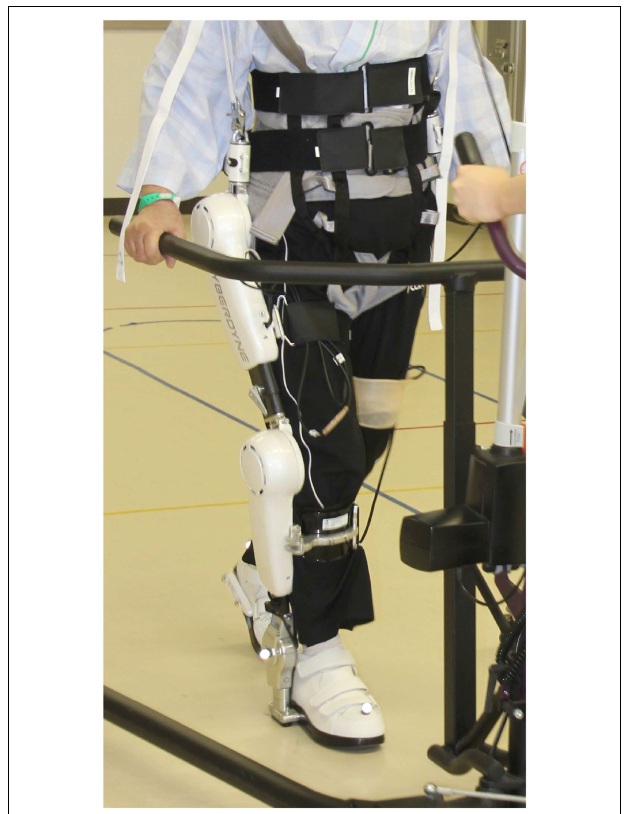
FIGURE 2 | Patient wearing HAL in a walking device (front view).